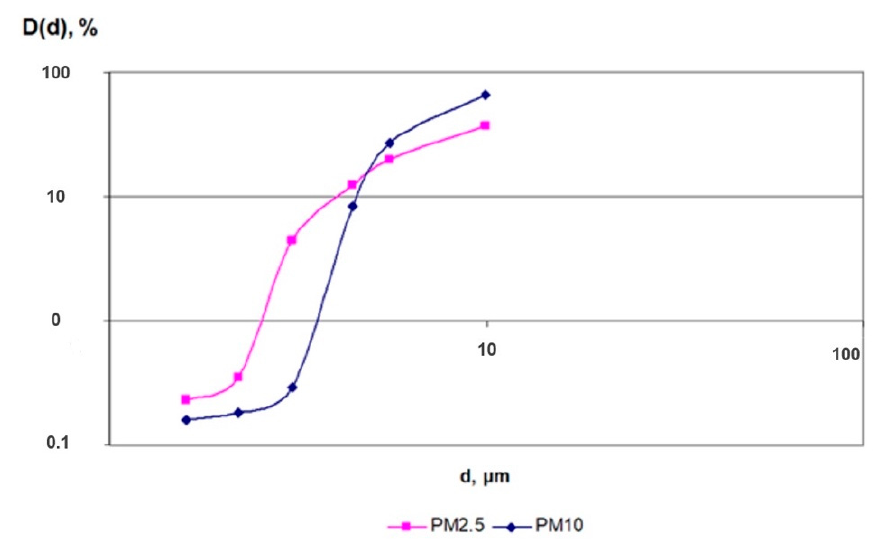
Figure 3. Integral curves of PM 2.5 and PM 10 fraction distribution in the air of urbanized areas. Figure 3 shows the percentage content dependence of dust particles D (%) for PM 2.5